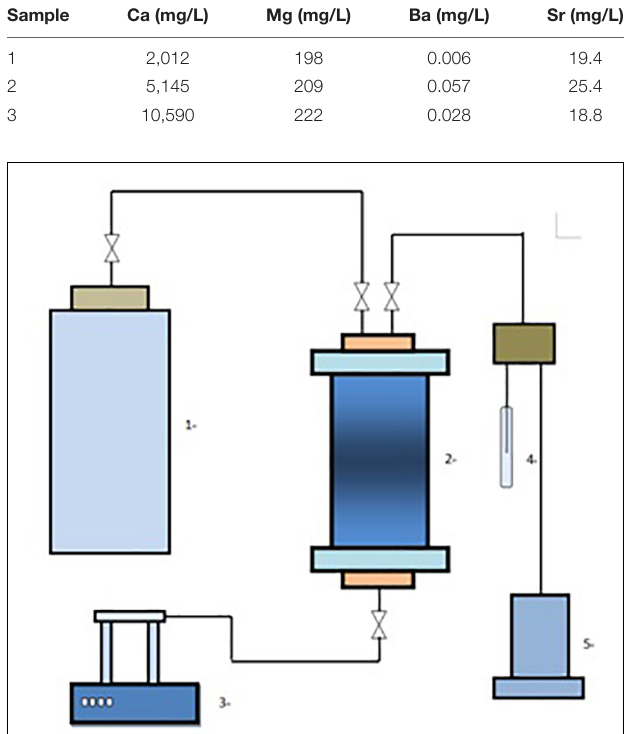
FIGURE 1 | Schematic diagram of the experimental device. (1, CO 2 gas tank; 2, high-temperature and high-pressure reactor; 3, ISCO pump; 4, test tube; 5, return pressure